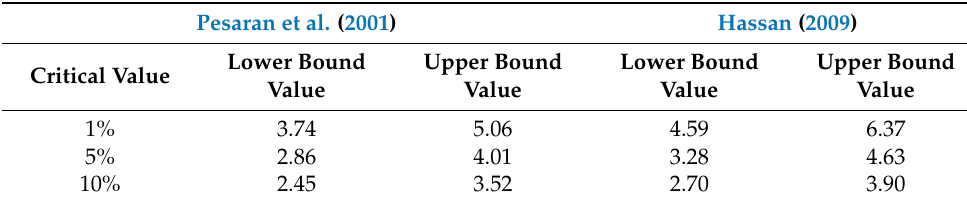
Table 4. Pesaran and Narayan critical value. Source: (Hassan 2009; Pesaran et al. 2001). Pesaran et al. (2001)